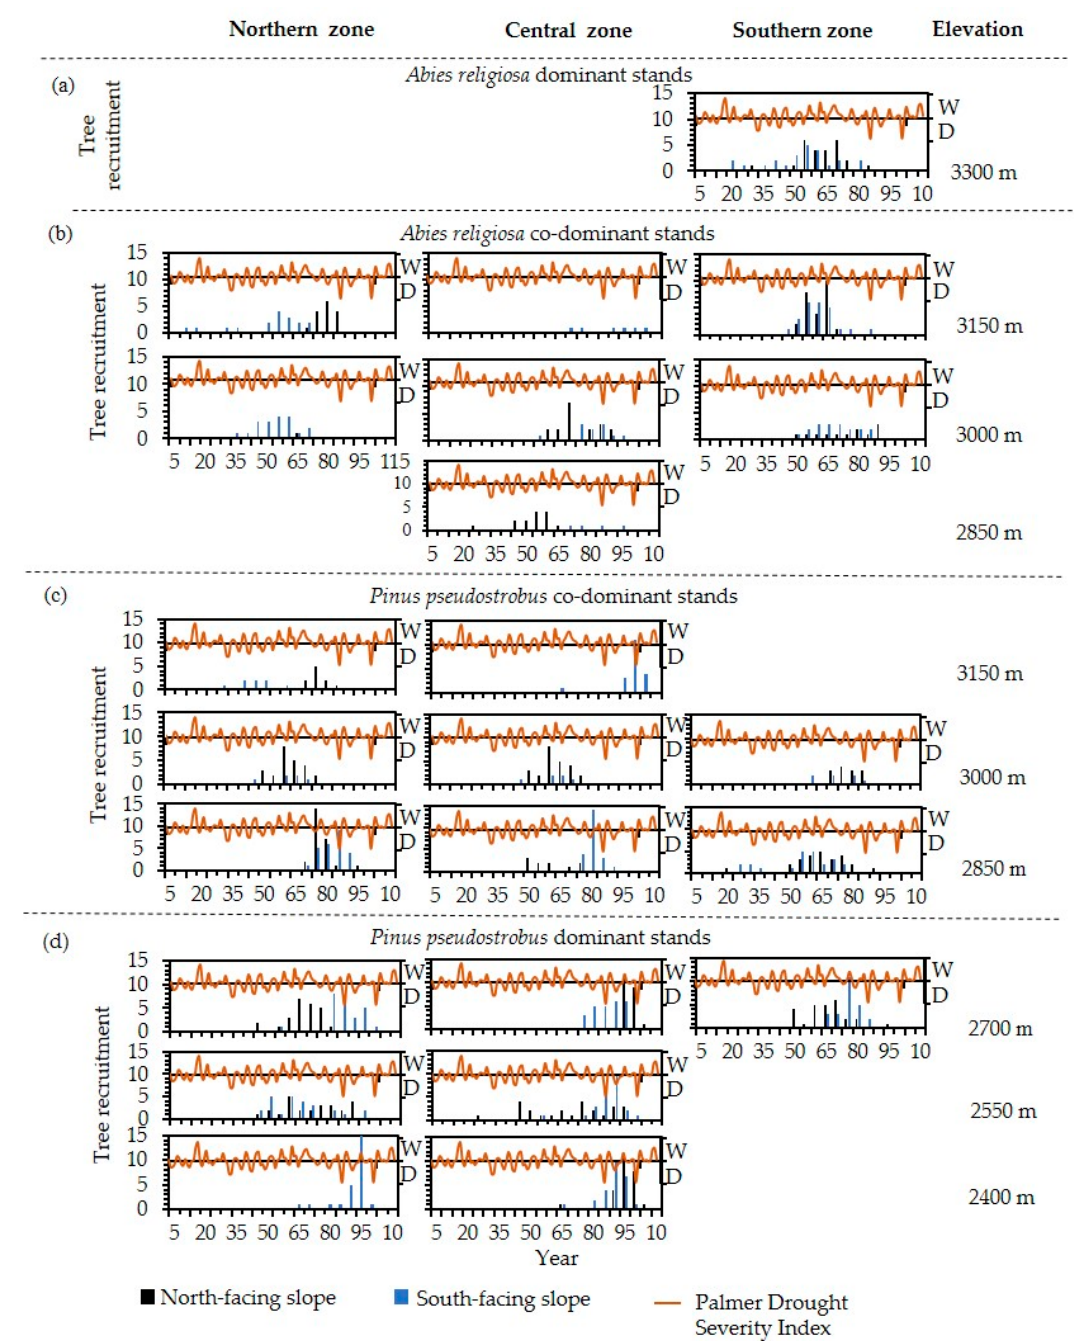
Figure 4. Establishment history in the MBBR, central Mexico, at different altitudes in ( a ) stands dominated and ( b ) co-dominated by A. religiosa , and in stands ( c ) co-dominated and ( d ) dominated by P. pseudostrobus . Years in which trees were established are plotted in 5-year intervals. Palmer Drought Severity Index values above line (W) indicate wet conditions, whereas values under the line (D) indicate dry conditions.